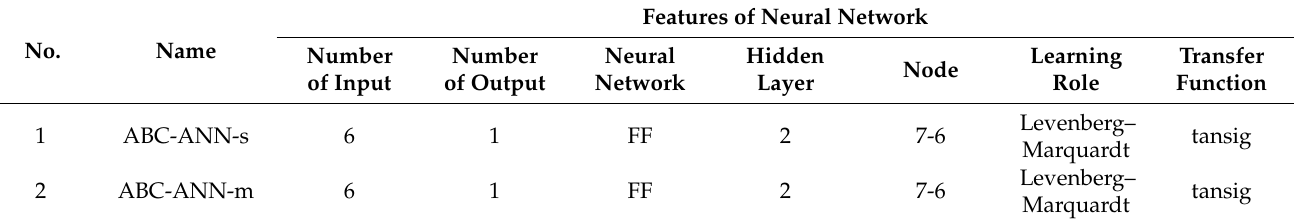
Table 4. Structure and topology of the feed-forward (FF) neural network.